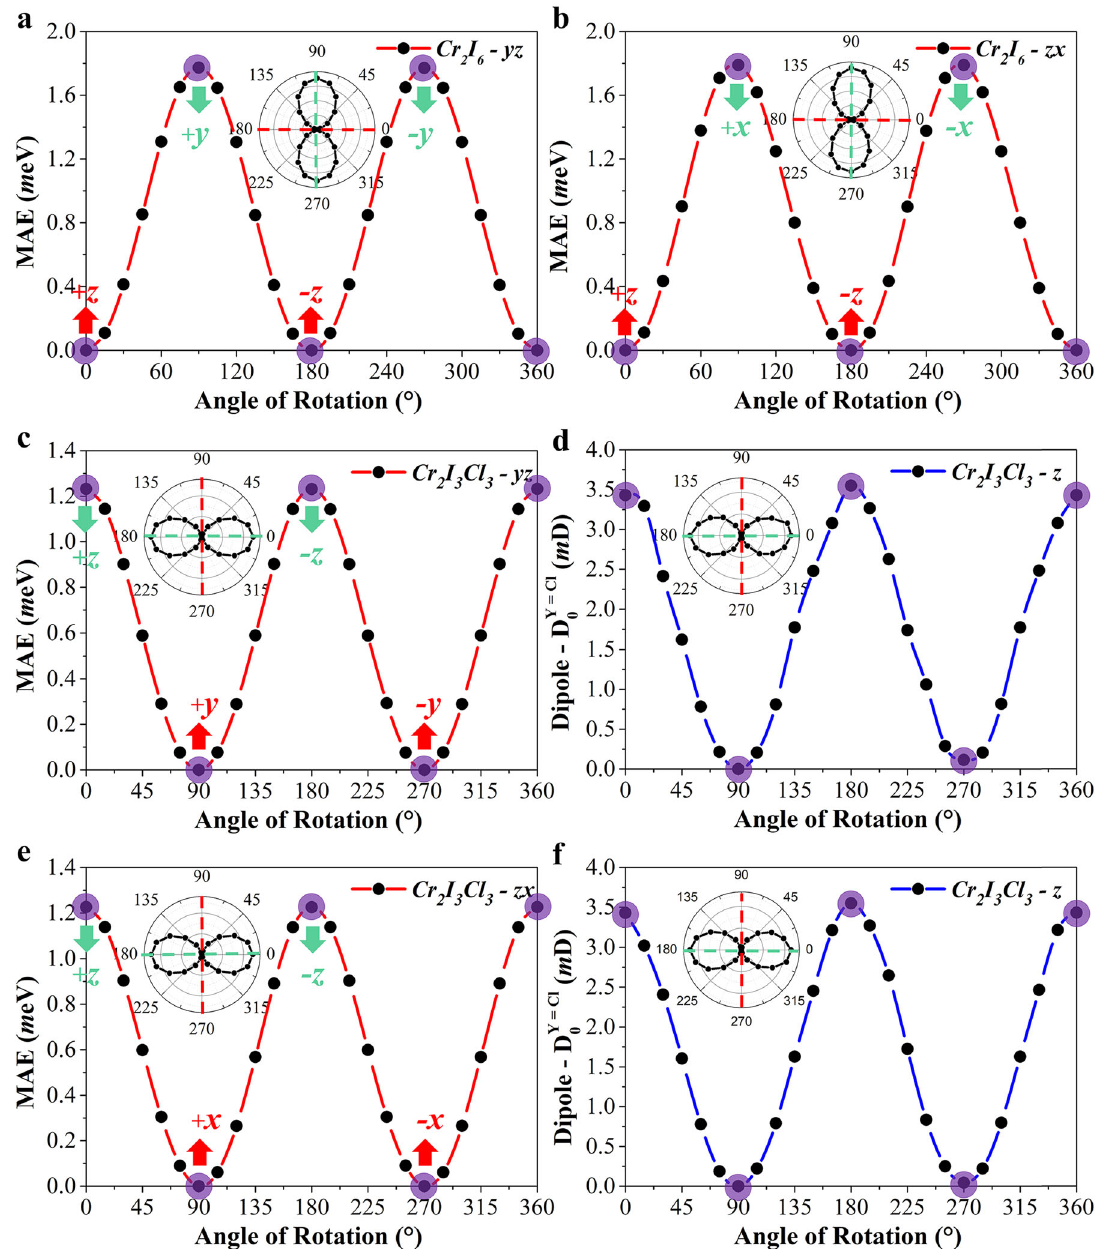
Fig. 6 The coupling between the EP dipole moment and MAE with spin rotation. MAE of Cr 2 I 6 monolayer and Janus Cr 2 I 3 Cl 3 with spin orientations for different rotation angles within ( a , c ) yz -plane, and ( b , e ) zx -plane, respectively. The corresponding electric dipole moment along the z direction of Janus Cr 2 I 3 Cl 3 for spin orientations in ( d ) yz -plane, and ( f ) zx -plane. The horizontal coordinate-axis refers to rotating angles of spin orientations with an interval of 15° starting from z -axis. Insets in ( a , b , c , and e ) are MAE corresponding to spin orientations in polar coordinates, and insets in ( d and f ) are dipole moments along the z direction corresponding to spin orientations in polar related to the spacing distance between I and Y atomic layers, and the vertical variation of the spacing can therefore be straightforwardly characterized by the parameter. ε d , de fi ned as ε ¼ ð d (cid:3) d Þ = d ´ 100 % , where d d z z represents the tunable perpen- dicular distance between the layer of I and Y atoms while d represents the special case of d z for fully optimized equilibrium